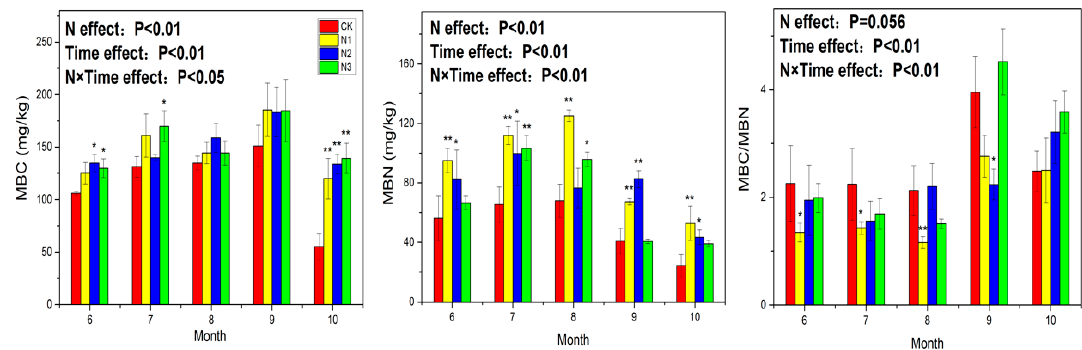
Figure 3. Responses of microbial biomass carbon (MBC), microbial biomass nitrogen (MBN), and MBC / MBN to N application in a subalpine coniferous forest. * indicates significant di ff erence between N treatment and control ( p < 0.05), ** indicates extremely significant di ff erence between N treatment and control ( p < 0.01) (repeated measures ANOVA, LSD multiple comparison).